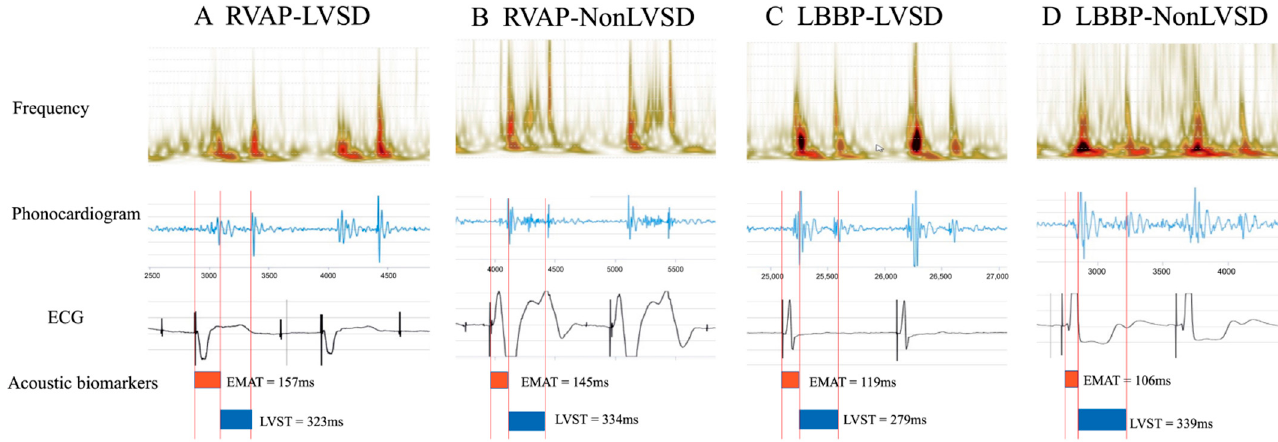
different Figure 4. Examples of cardiac acoustic and ECG waveforms and automatic analysis results in dif- ferent groups.